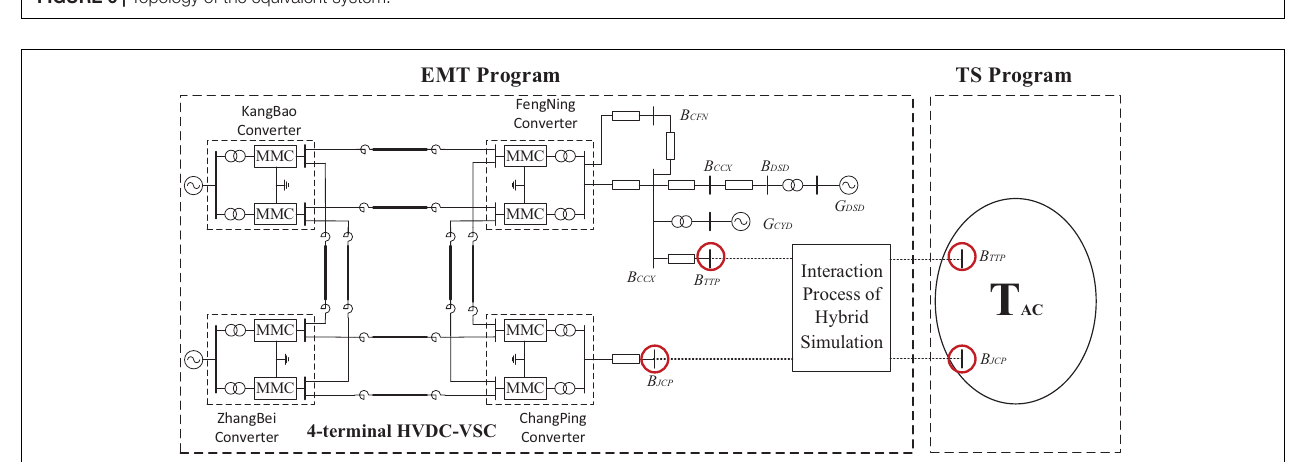
FIGURE 6 | Topology of the equivalent system.